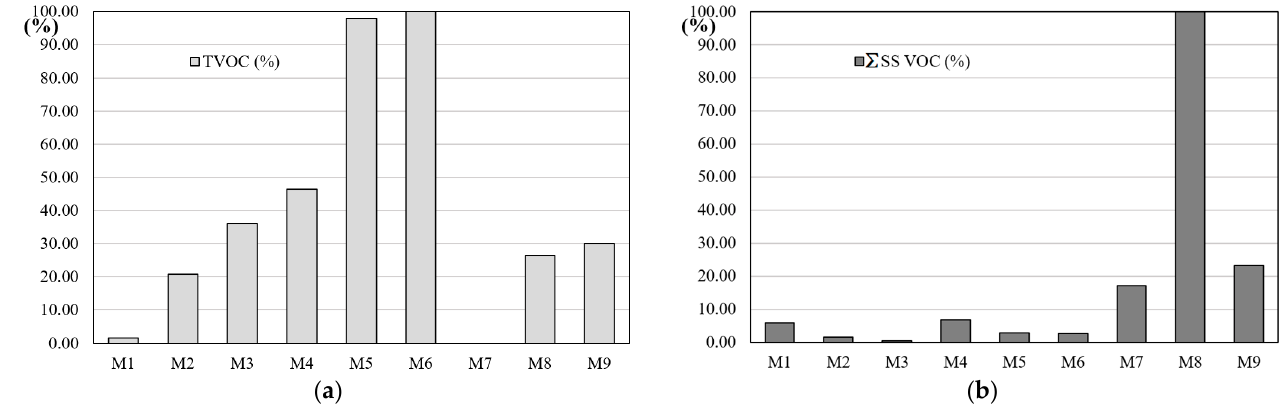
Figure 3. Exposure to VOCs from the facemasks’ materials by ( a ) inhalation (TVOC) and ( b ) dermal contact (sum of skin ‐ sensitizing VOCs ( SS VOC)).